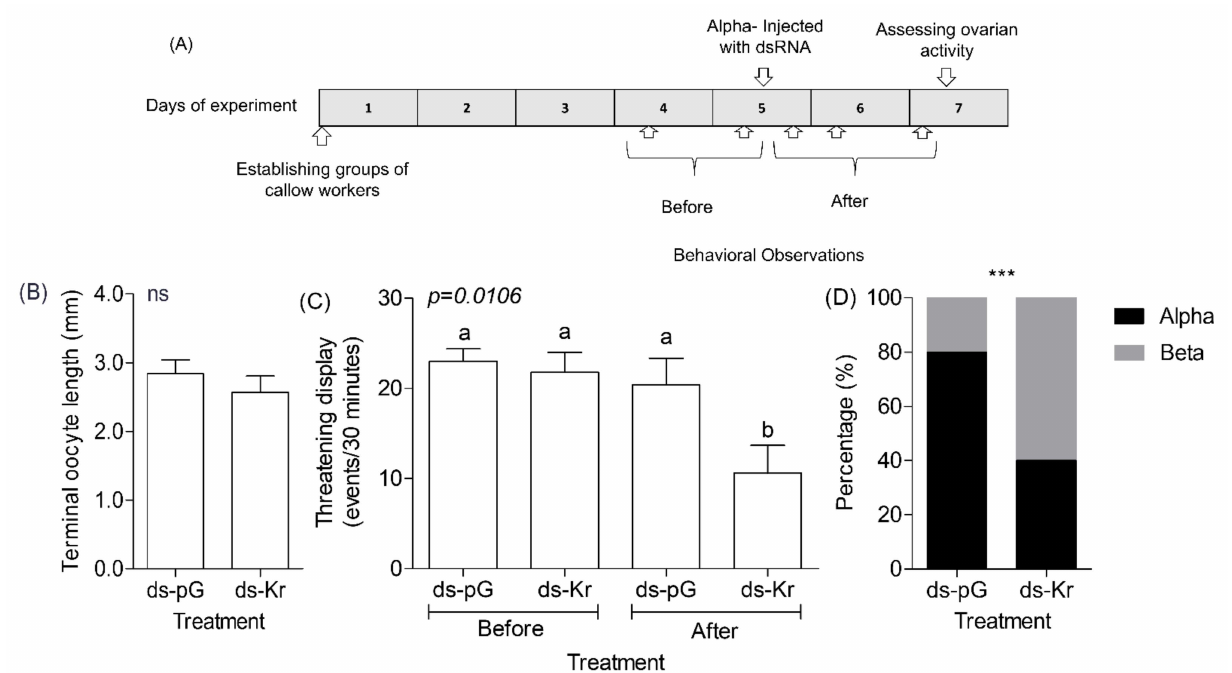
Figure 4. The influence Kr-h1 knock-down on behavior and ovarian activity of dominant queenless bees in established dominance hierarchies. ( A ) Experimental outline. ( B ) Ovarian activity at seven days of age of dominant (alpha) bees injected with Kr-h1 dsRNA ( ds-kr ) or control dsRNA ( ds-pG ). ( C ) Threatening displays of dominant bees injected with Kr-h1 or control dsRNA before or after injection; the values before injection are the average of the observations in days 4 and 5, and the values after injection are the average of the observations in days 5 (after injection), 6, and 7. Treatments marked with different small letters are statistically different in two-way ANOVA analysis followed by Bonferroni post-hoc analysis. ( D ) Dominance rank of alpha bees after injection with either Kr-h1 or pG dsRNA. The vertical bars (in B , C ) depict mean ± SE. n = 5 bees per treatment group. ***— p < 0.0001, in Chi-square with Yates’